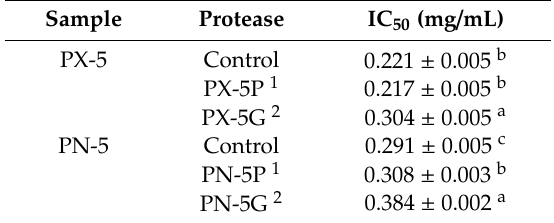
Table 2. ACE activity inhibition of PX-5 and PN-5 obtained from gastrointestinal protease hydrolysis. Sample Protease